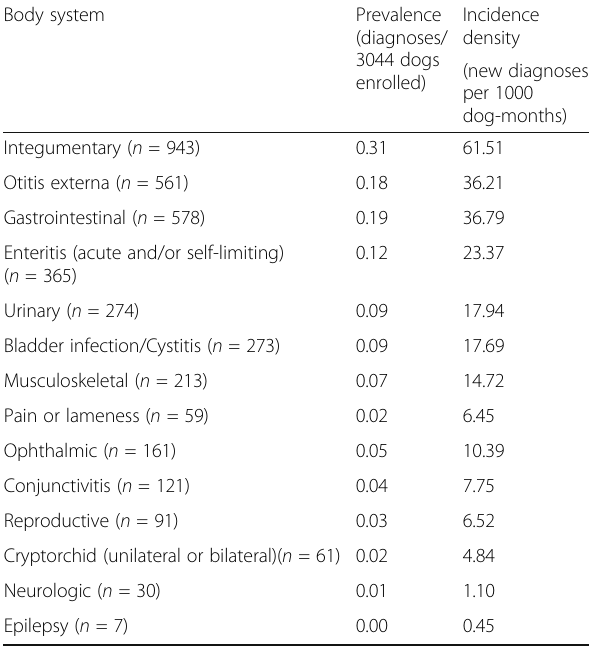
Table 4 Prevalence and incidence density of diagnoses by body system and the most common diagnosis within systems in a cohort of 3044 Golden Retriever dogs during the